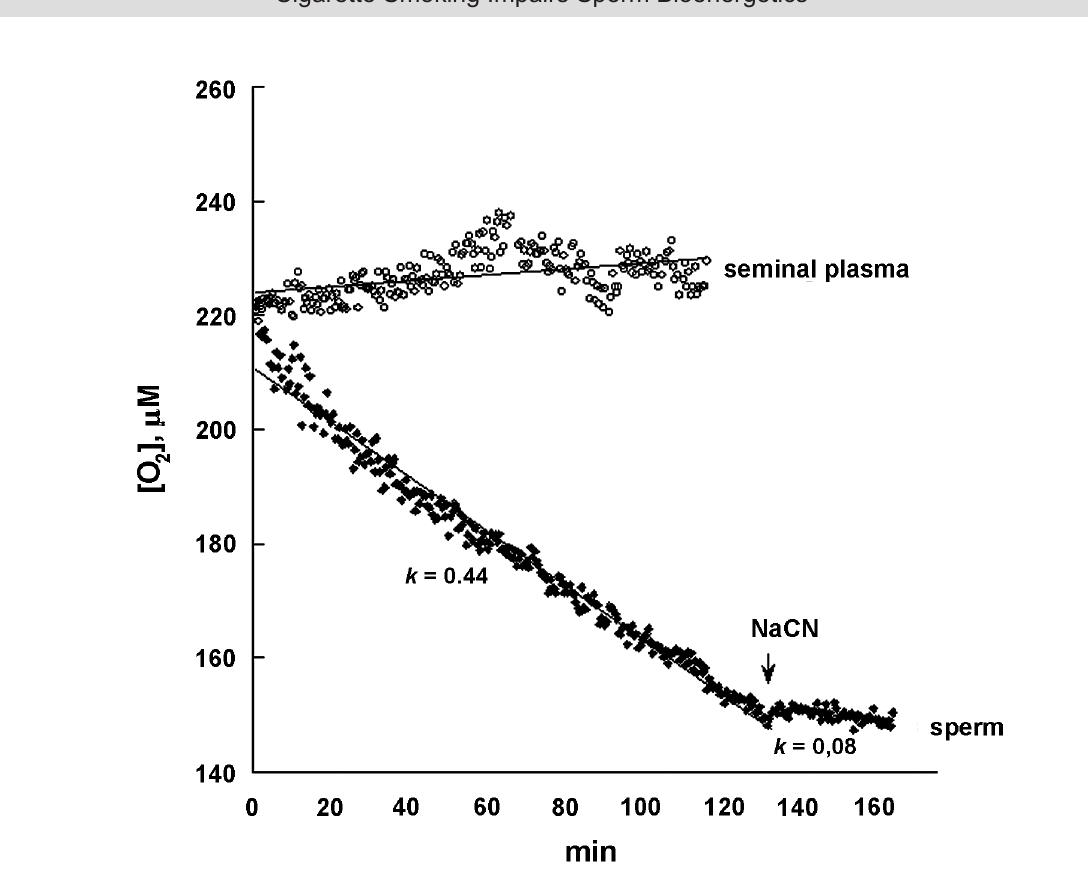
Figure 1 – Representative plot of O consumption as function of time in sperm and seminal plasma from a smoker. O 2 was not observed in the seminal plasma without sperm (open circles). [O ] declined linearly with time in the sperm suspension (closed 2 diamonds). The decline in [O ] was inhibited by 87% after the addition of NaCN, confirming the oxidations occurred in the sperm mi- 2 tochondrial respiratory chain. Best-fit curves (r 2 = 0.978) and values of k ( µ M O min -1 per 10 8 sperm) are 2